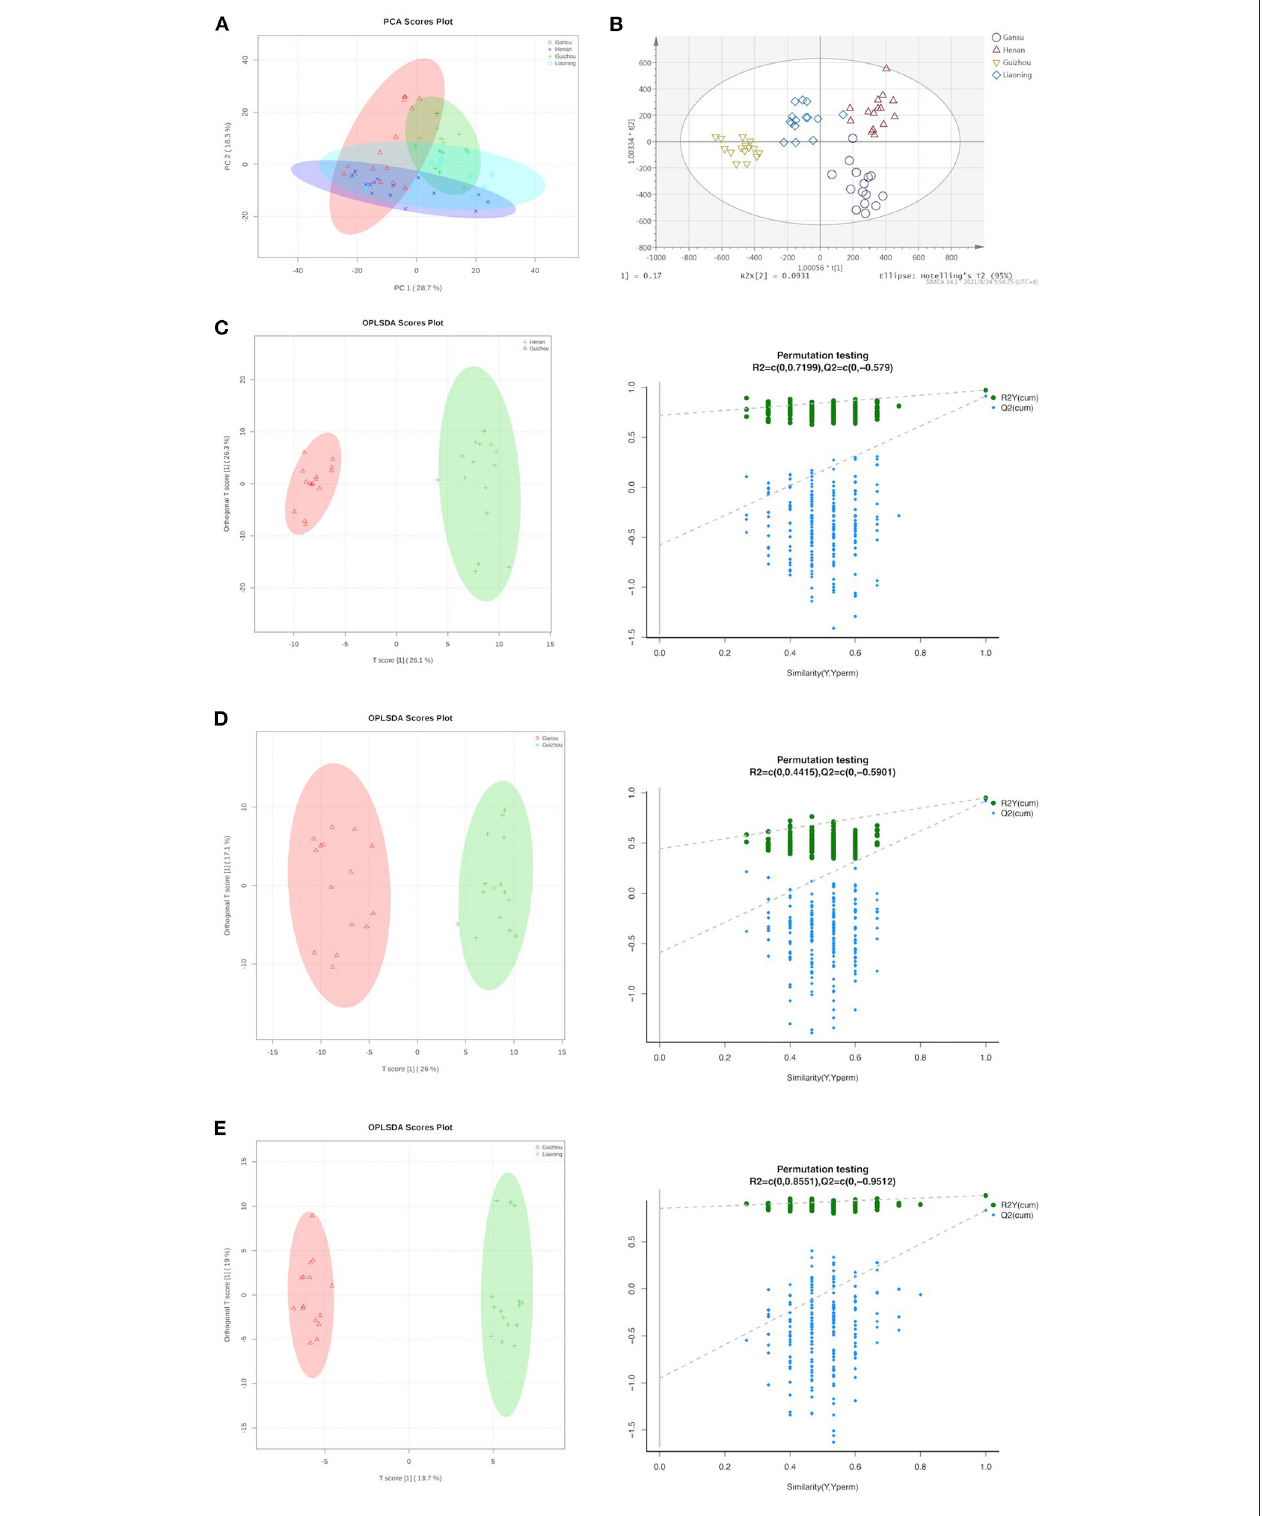
FIGURE 2 | Supervised and unsupervised multivariate analysis based on metabolomic data of morels. (A) Score plot of principal component analysis. (B) Score plot of orthogonal partial least squares discriminant analysis. (C) OPLS-DA scores plot and permutation testing between Henan and Guizhou. (D) OPLS-DA scores plot and permutation testing between Gansu and Guizhou. (E) OPLS-DA scores plot and permutation testing between Guizhou and Liaoning.